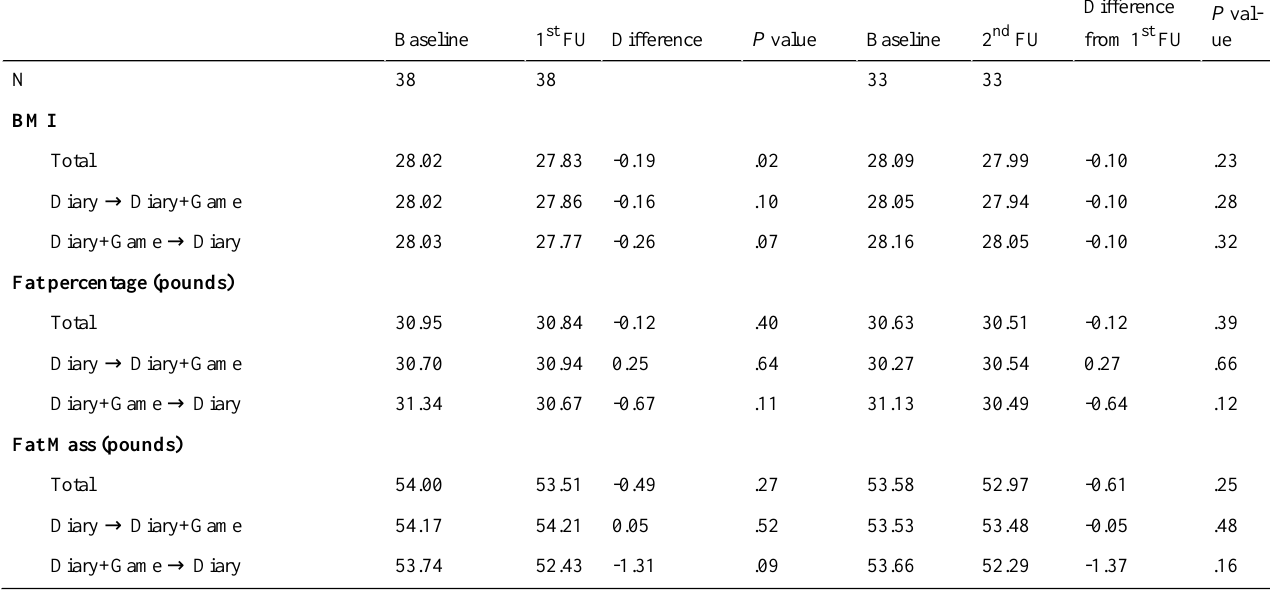
Table 4. Anthropometric measures by study condition. a